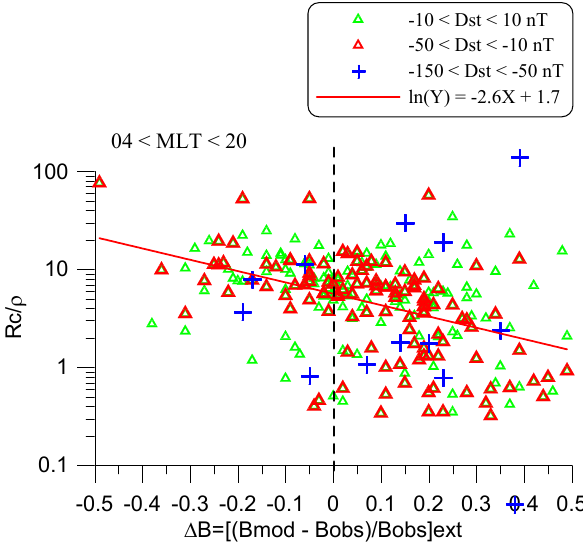
Fig. 7. Dependence of the computed values of R c /ρ on − B obs the accuracy parameter 1B = B T 01 corresponding to the B obs Polar IDB observations on the nightside (04 <MLT < 20) for − 10nT <D st < 10nT (green triangles), − 50nT <D st < − 10nT (red triangles) and − 150nT <D st < − 50nT (blue crosses). Here the in- terval of 1B from − 0.5 to 0.5 is shown as it represents good accu- racy. The red line represents the fit ln(R c /ρ) = − 2.6 1B